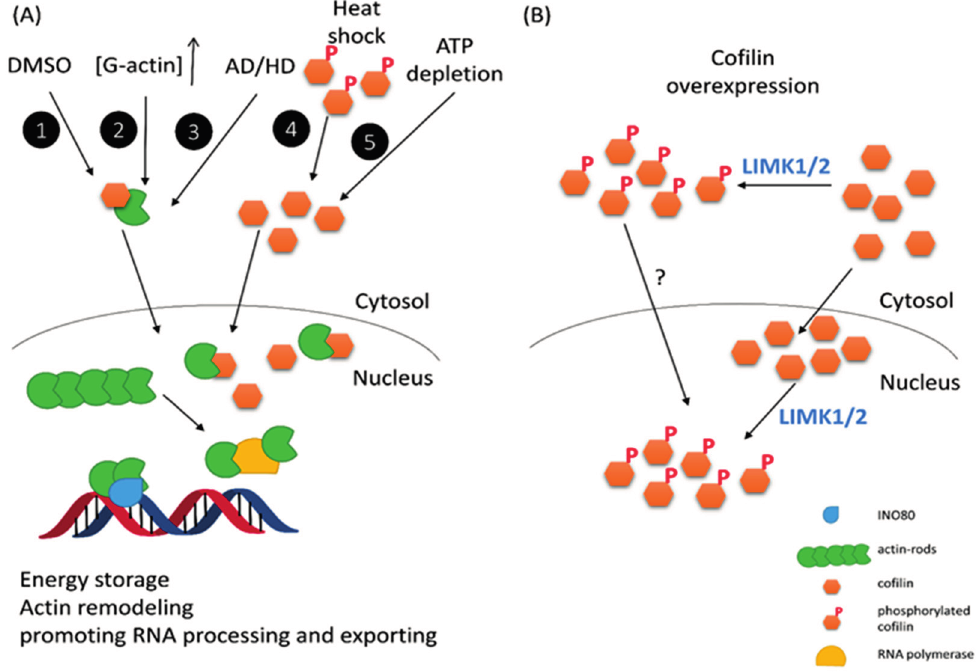
Figure 1. Nuclear entry of Cofilin-1 (CFL-1) via various stresses. ( A ) CFL-1 can